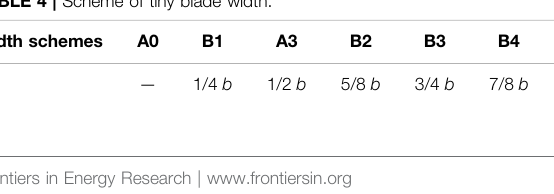
TABLE 4 | Scheme of tiny blade width.